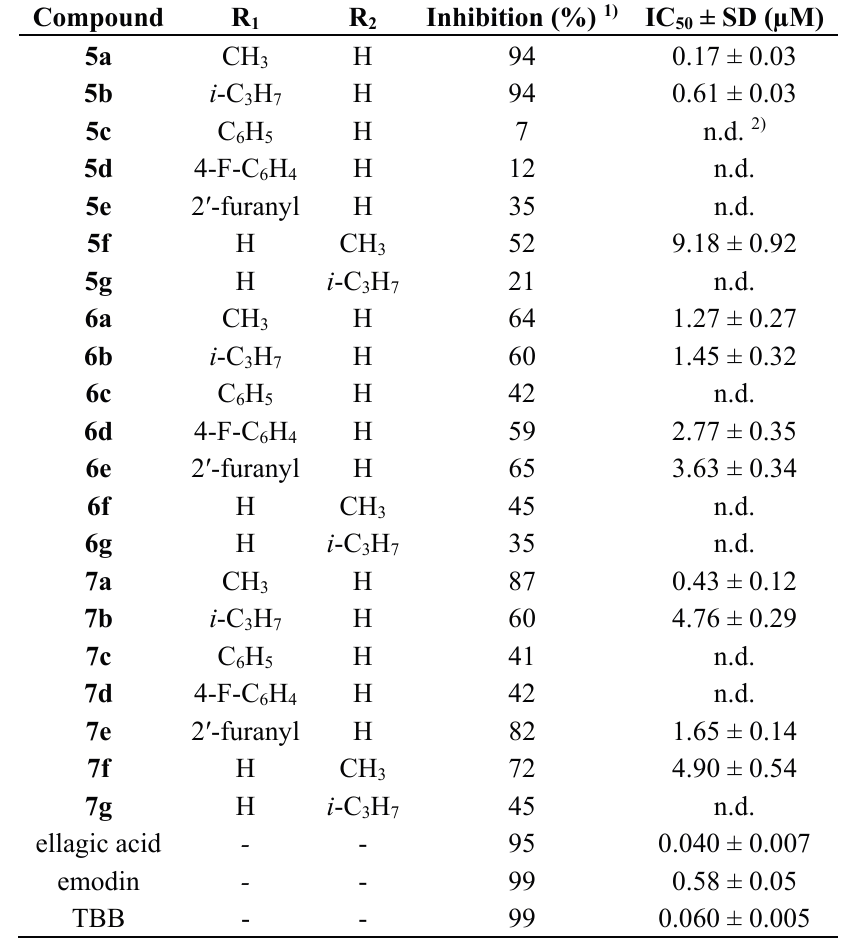
Table 1. Synthesized indeno[1,2- b ]indole derivatives and inhibition of human CK2